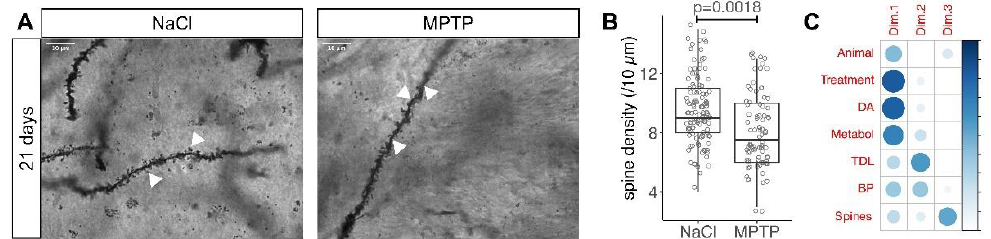
Figure 3. Spine density in MSN 21 days after MPTP. ( A ) Representative images of Golgi-stained MSN dendrites (arrowheads) 21 days after the last MPTP injection. Scale bars 10 µ m. ( B ) Number of spines in a 10 µ m stretch of dendrite. Each marker represents one MSN. Numbers of MSN are in Table 1. p -value is from Mann–Whitney test. ( C ) Illustration of the principal component analysis with size and color of the blue circles representing the importance (cos 2 ) of the factor in that row for the dimension in that column.